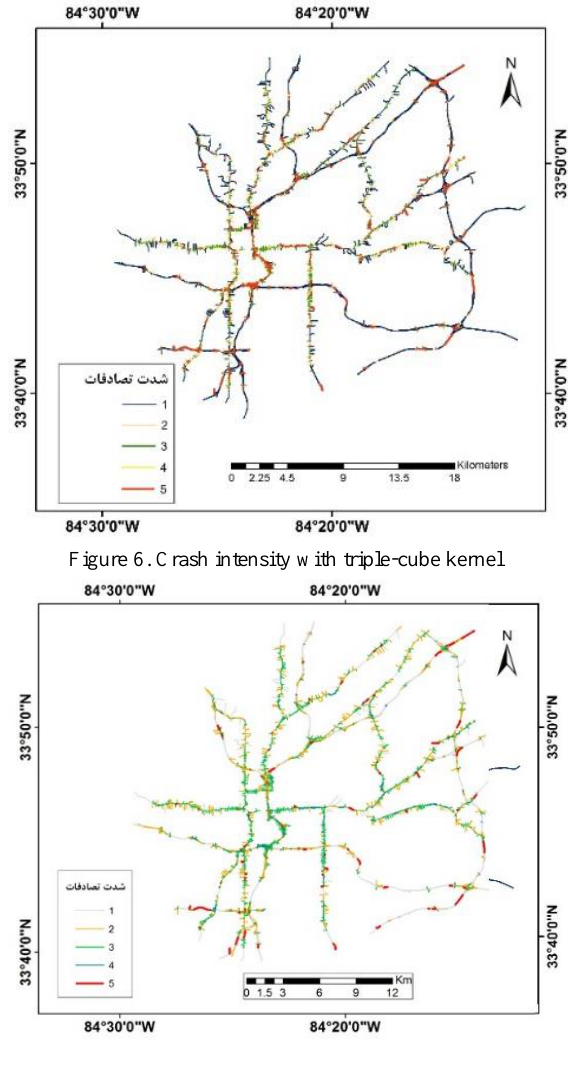
Figure 7. Crash intensity with Gaussian kernel